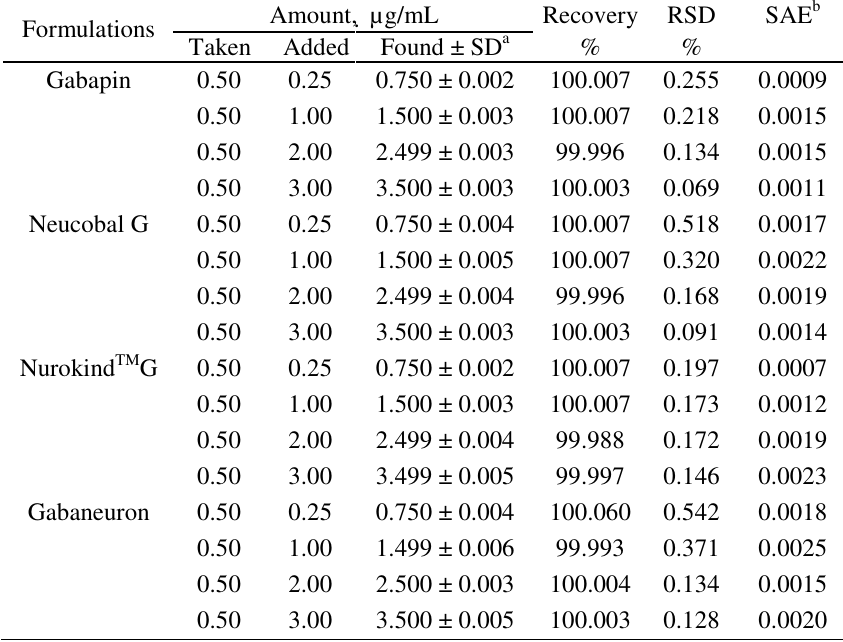
Table 4. Summary of data for the determination of gabapentin in pharmaceutical preparations by standard addition